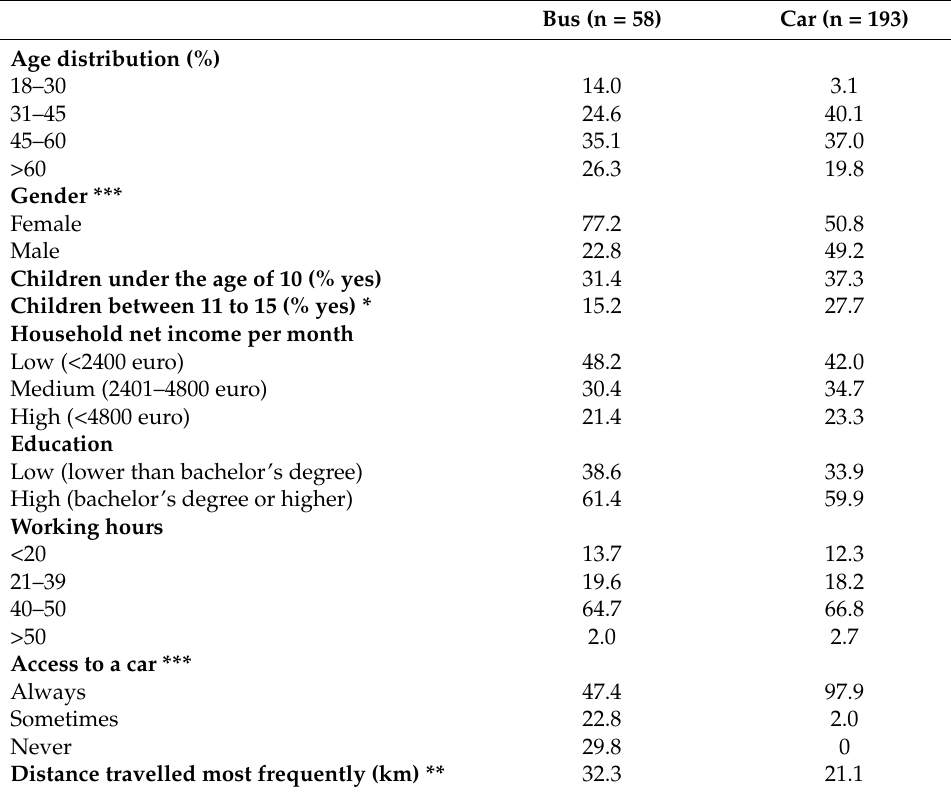
Table 4. Socio demographic factors: bus users and car